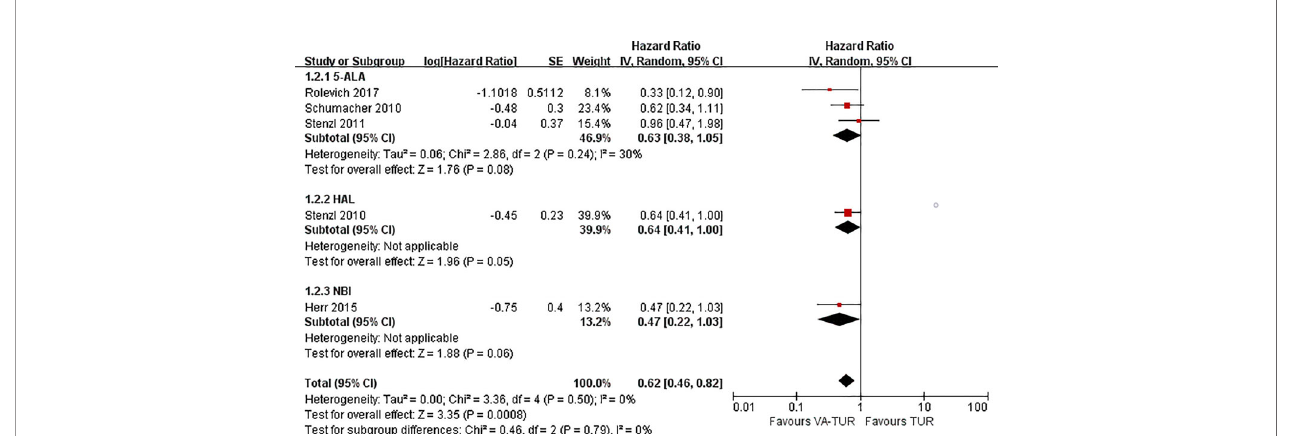
FIGURE 6 | Forest plot of PFS of VA-TUR versus TUR subgrouped by types of visualization methods.